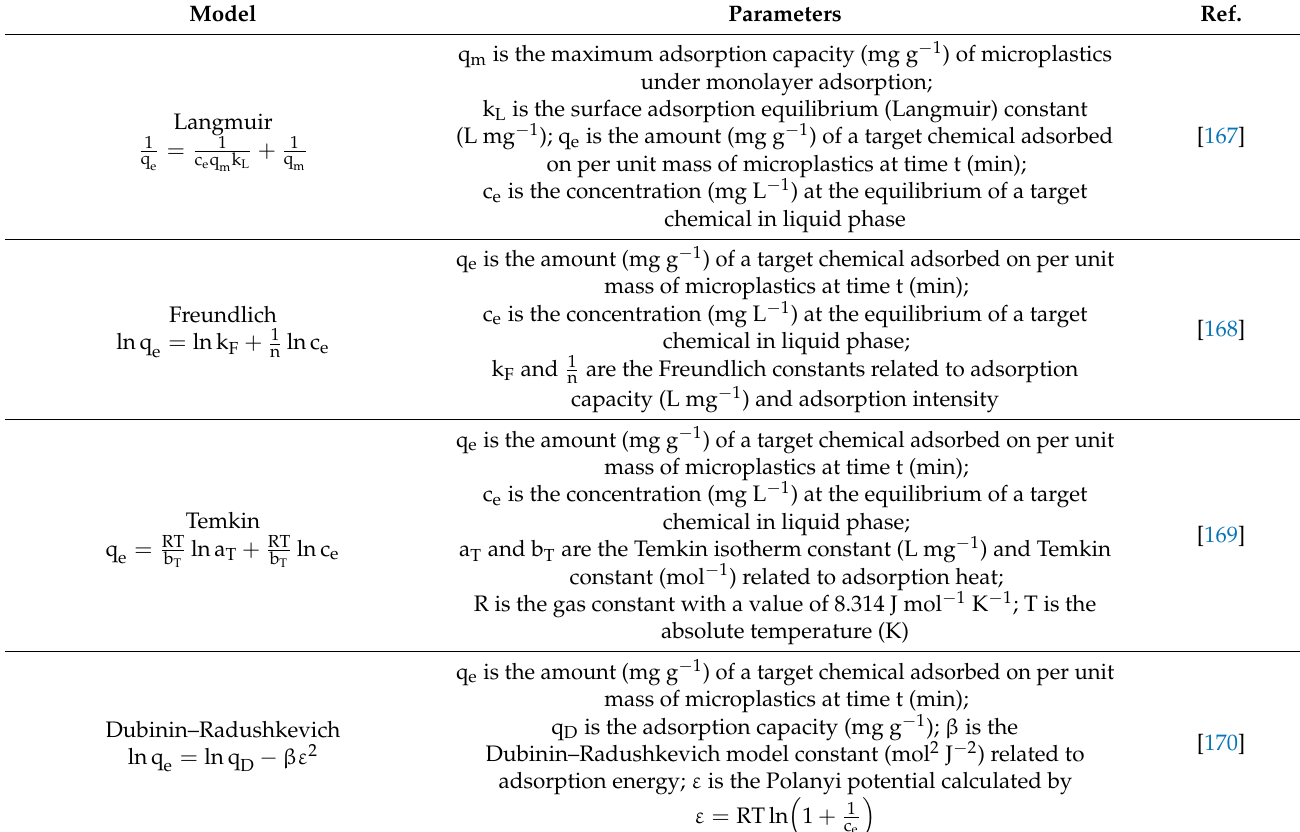
Table 2. Adsorption isotherm